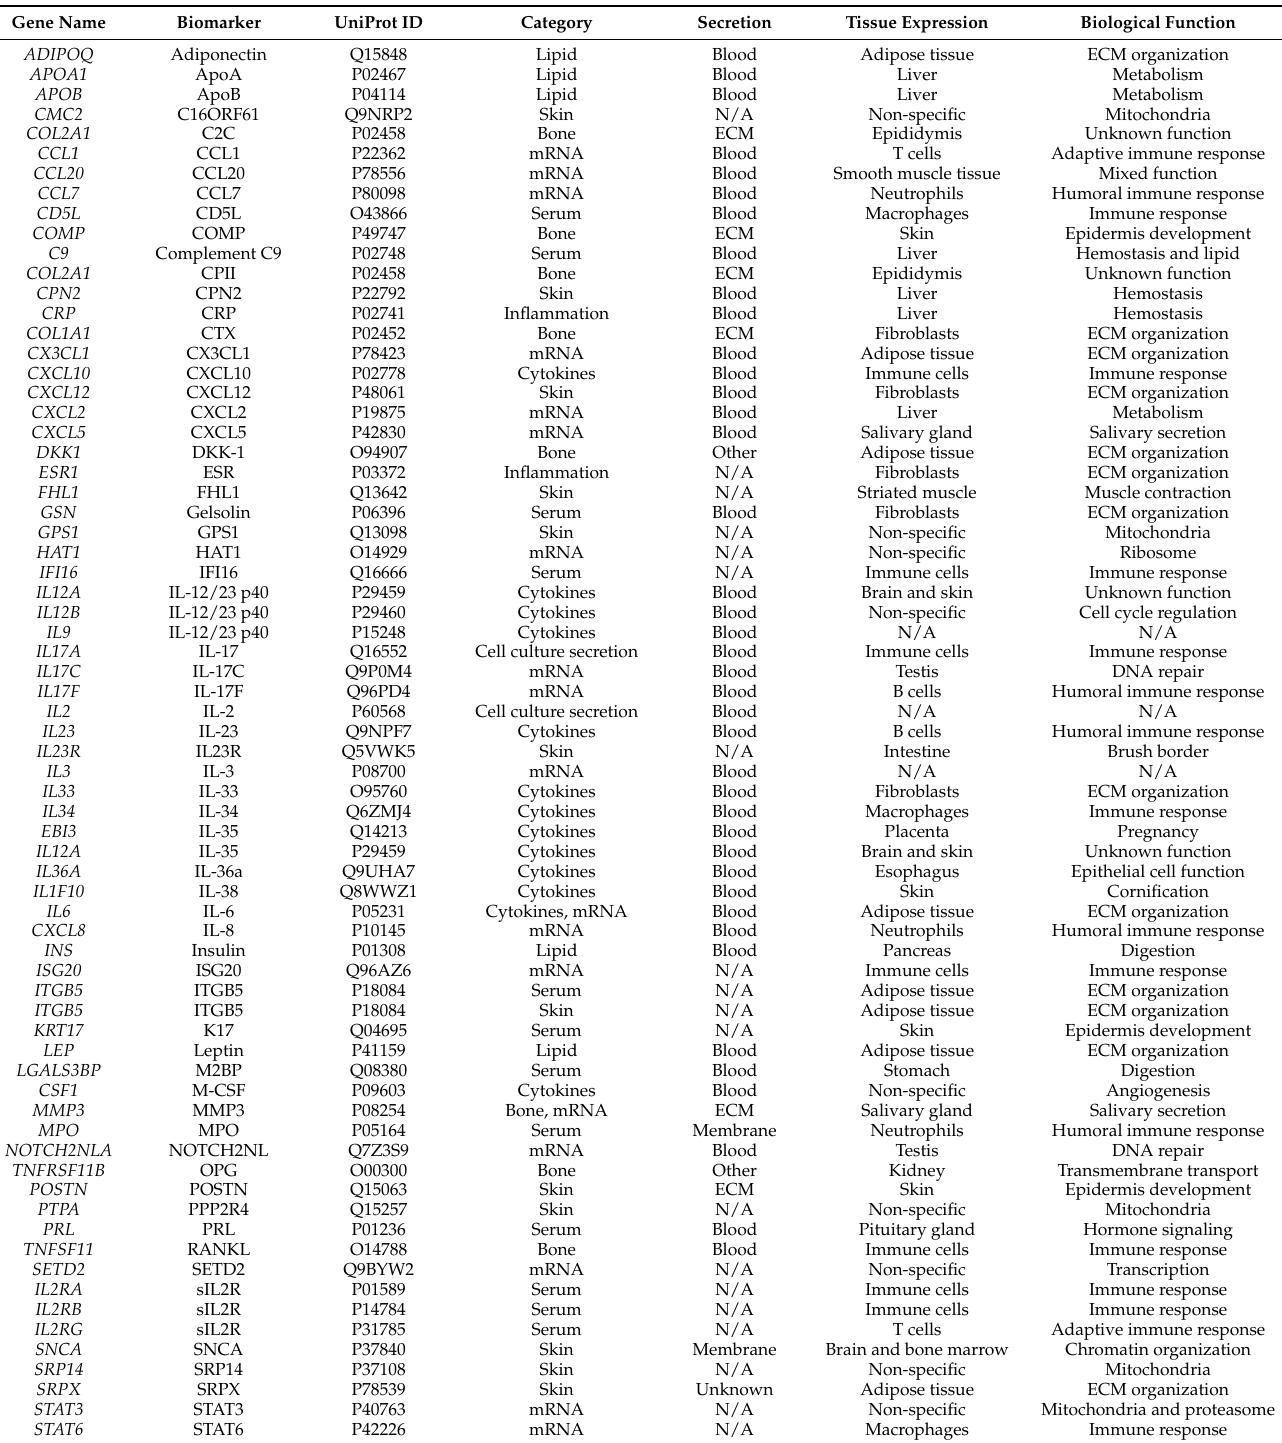
Table 2. Proteomic markers with evidence to support their ability to distinguish between PsA and cutaneous-only psoriasis. A gene-centric table of candidates was created by using the biomarkers listed by Mulder et al. [73]. The proteins and mRNAs were converted into gene-centric entries using the Human Protein Atlas portal (www.proteinatlas.org (accessed on 5 July 2022)), and were annotated for secretion location, tissue expression and biological functional based on the recent clustering of single-cell expression data